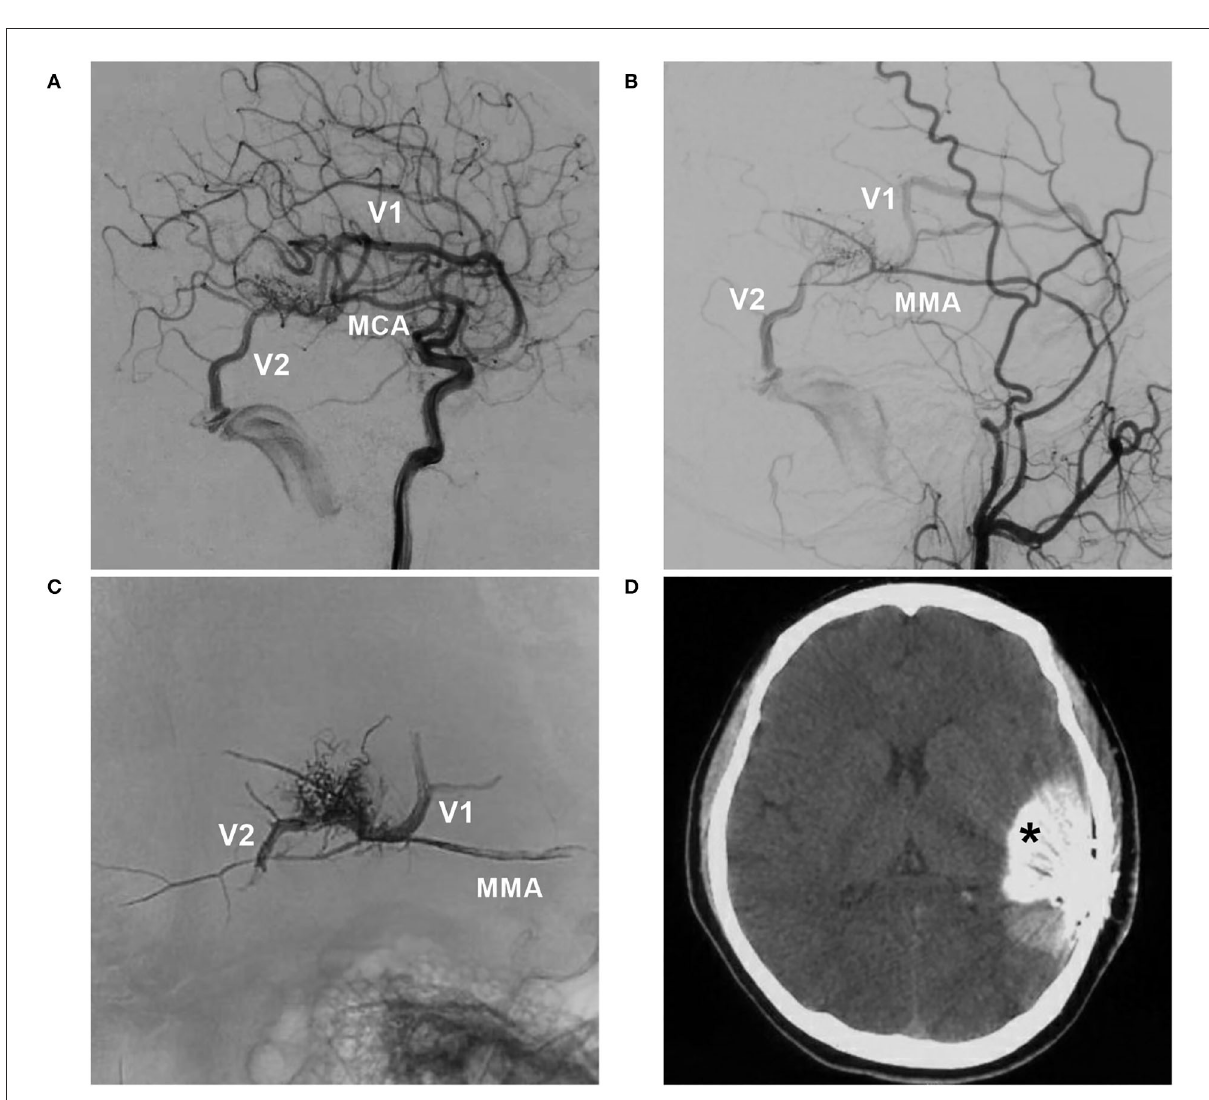
FIGURE4 BAVM with intraoperative nidus rupture (case 18). (A,B) Arterial-phase angiograms of the internal carotid artery and external carotid artery showing the BAVM supplied by the MCA and MMA, with two draining veins (V1 and V2). (C) X-ray film showing Onyx casting via the MMA and occlusion of the two draining veins. (D) CT showing contrast agent extravasation (asterisk). BAVM, brain arteriovenous malformation; MCA, middle cerebral artery; MMA, middle meningeal